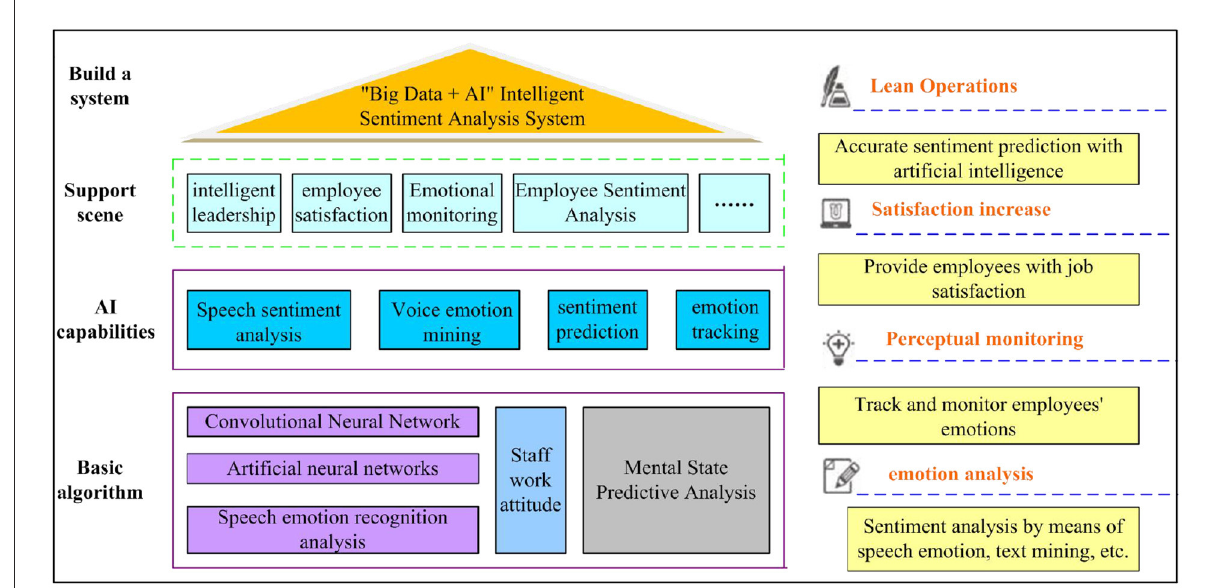
FIGURE1 The charismatic leader based on artificial intelligence emotional computing analyzes employee sentiment map.